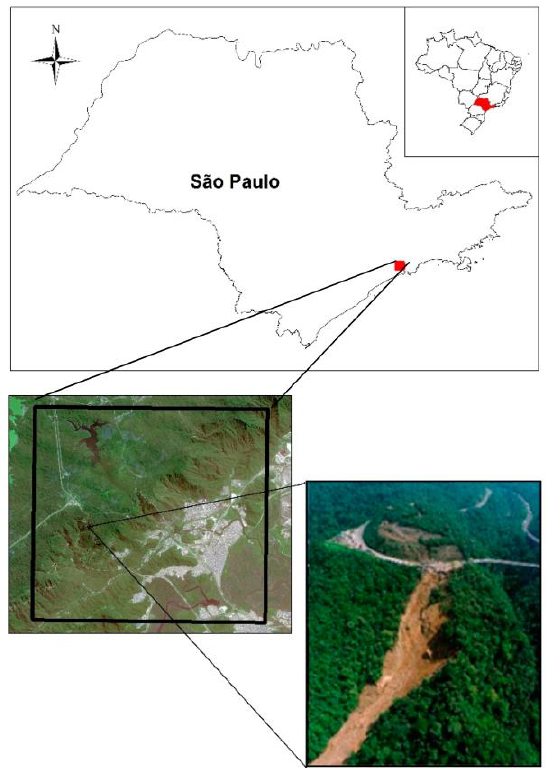
Figure 1. Location of the study area (Black Square) and a picture of the landslide scar at the Pilões watershed. Source: Landslide picture from [32].